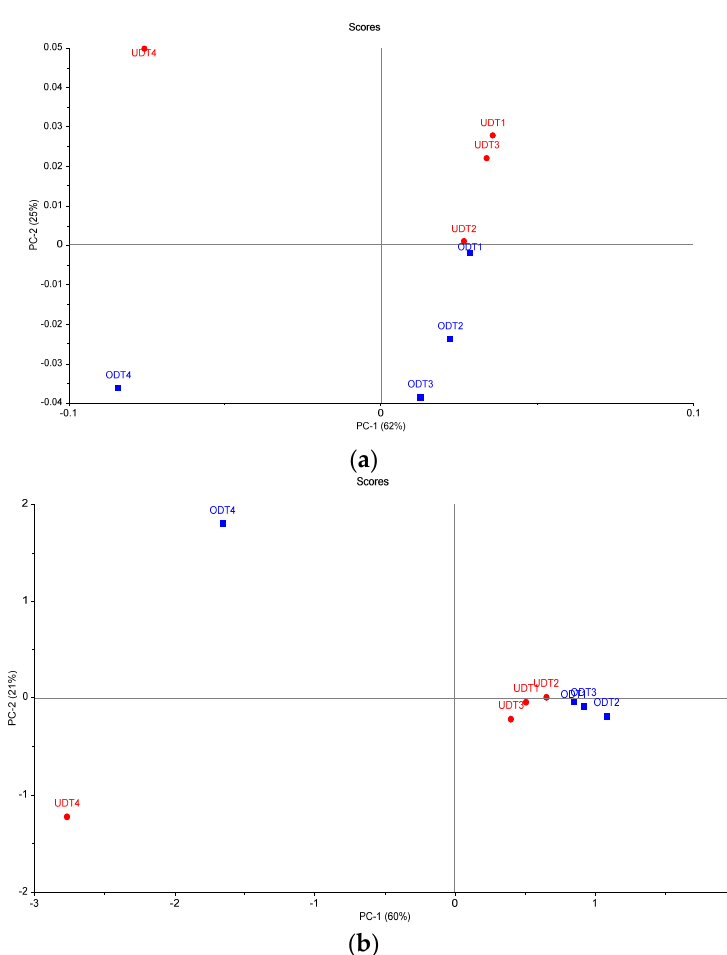
Figure 5. Principal component analysis (PCA) scores, for raw ( a ) and SNV-treated ( b ) FTIR spectra of oils and oleogels in the wave range of 600–4000 cm − 1 .